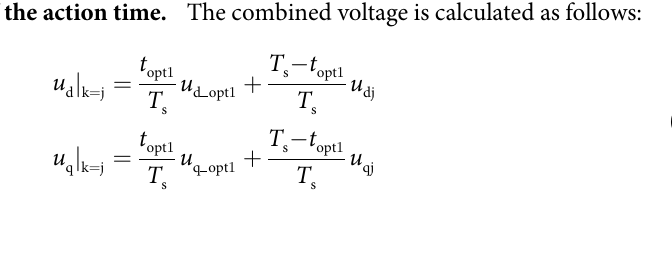
, V , and V adjacent to 2 4 0